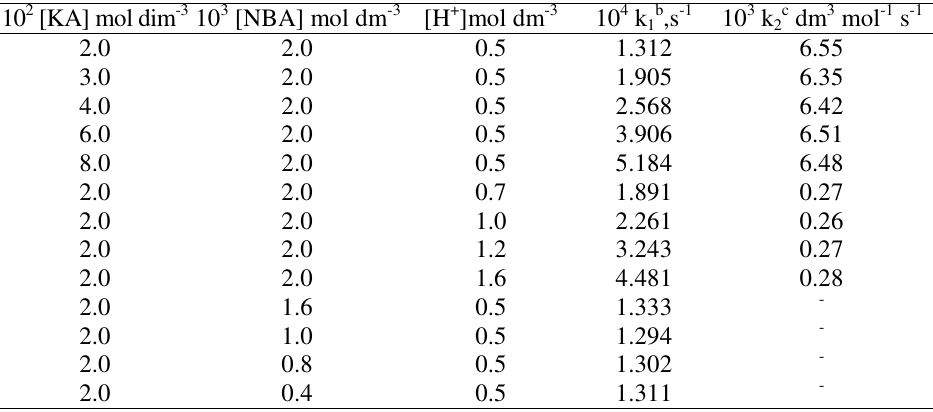
Table 1. Rate constant for the oxidation of 3-benzoylpropionic acid by NBA in aqueous acetic acid medium at 30 0 C